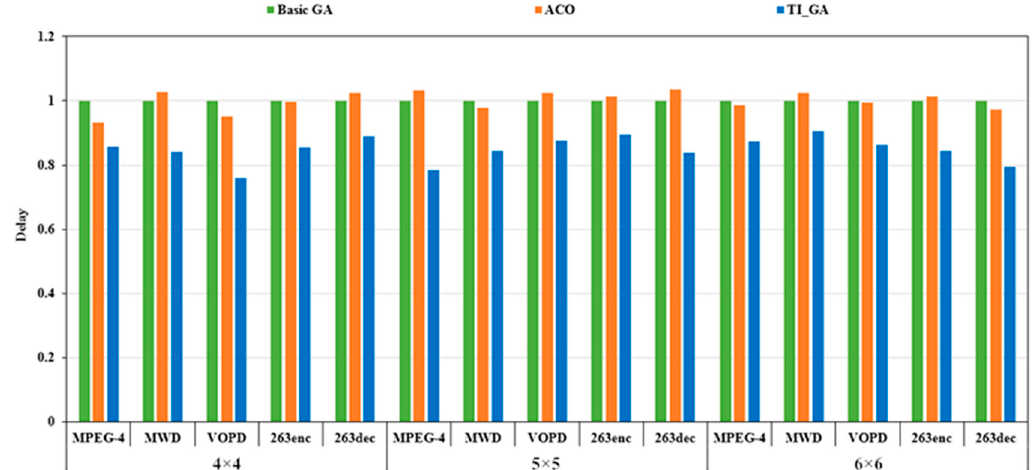
Figure 7. TI_GA, traditional genetic algorithm and ACO for MPEG-4, MWD, VOPD, 263enc, 263dec delay results comparison ( μ d = 1, μ e = 0).